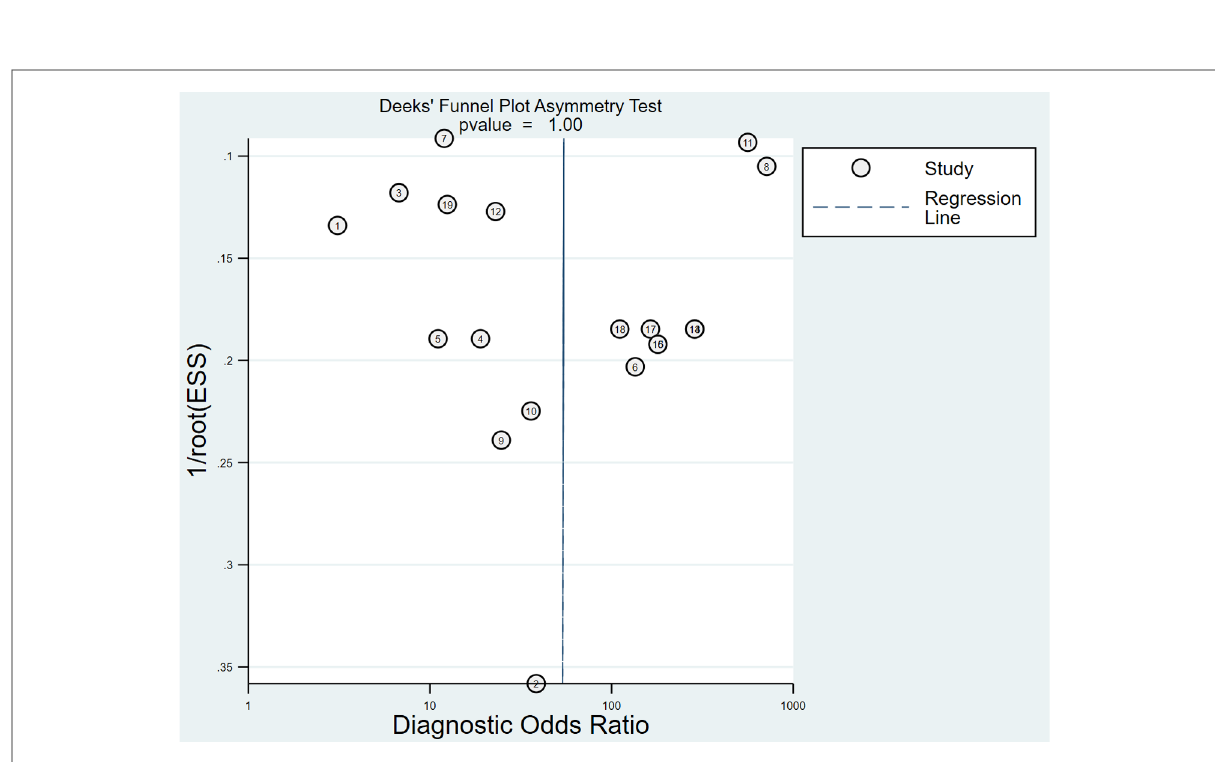
Figure 6 Funnel plot of MRI for the diagnosis of